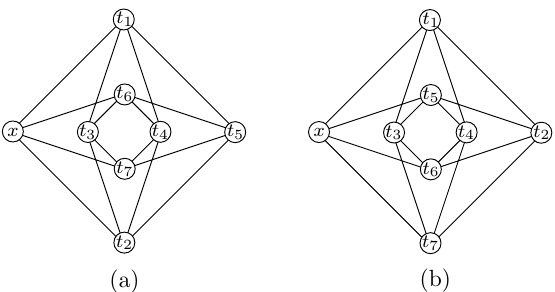
Figure 11. Positions of the x and t variables in a Chimera graph cell for the optimization problem ( a ) in the single-row embedding, and ( b ) for the extra gadgets in the multi-row